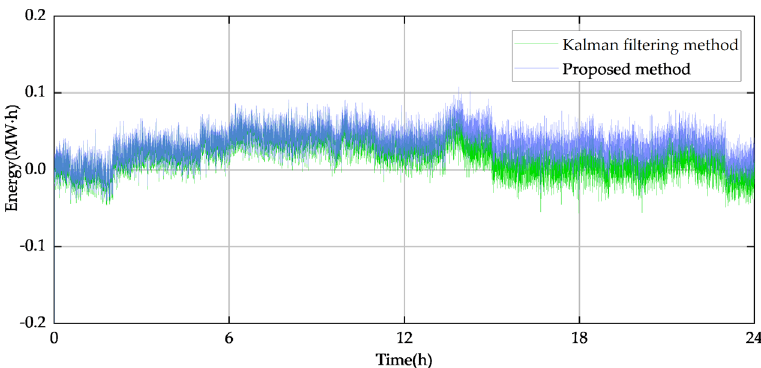
Figure 21. The energy change curve of the super capacitor.